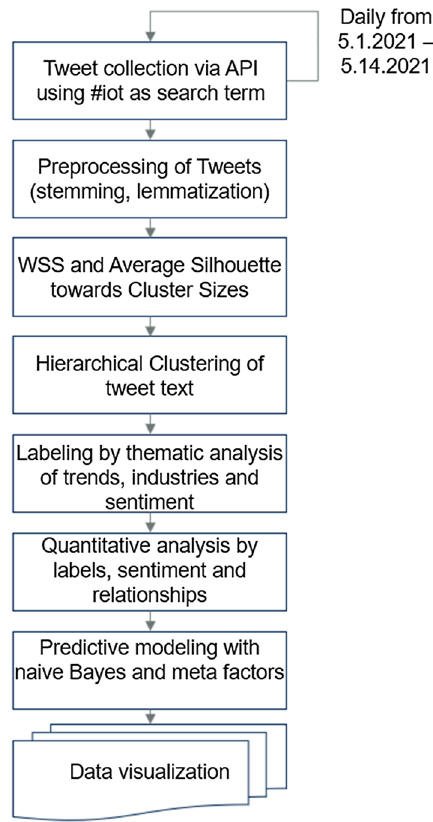
Fig. 2 Output of the within- cluster sum of squares method to determine the proper number of clusters to be generated. The method indicated that four clusters were appropriate for the IoT tweets